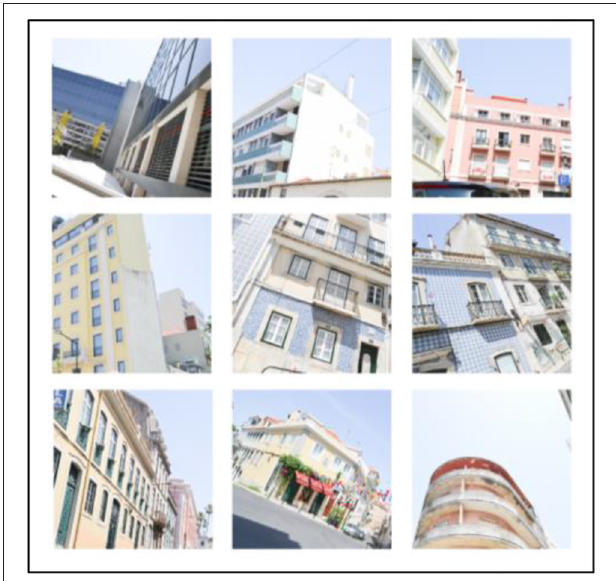
FIGURE A2 | Some examples of the randomly shot photographs from study